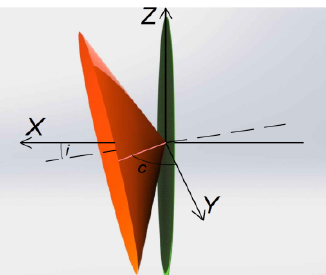
Figure 1. Tilted cone within which the collimation axis moves